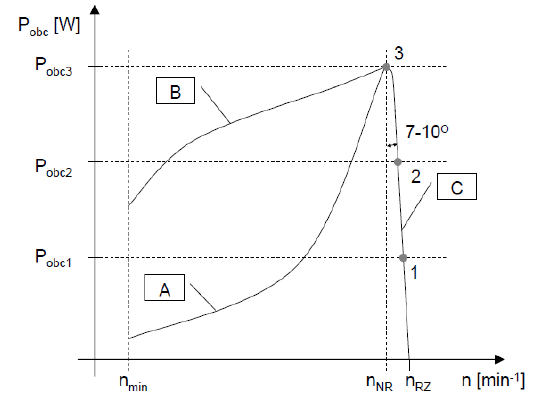
Fig. 4: Characteristics of the ship engine load variation as a function of the crankshaft rotational speed: A – screw speed characteristics (variable fuel feed per engine operating cycle); B – external speed characteristics (fixed fuel feed per engine operating cycle), C – regulator characteristics (varia- ble fuel feed per engine operating cycle), n NR – speed regulator setting, n RZ – actual